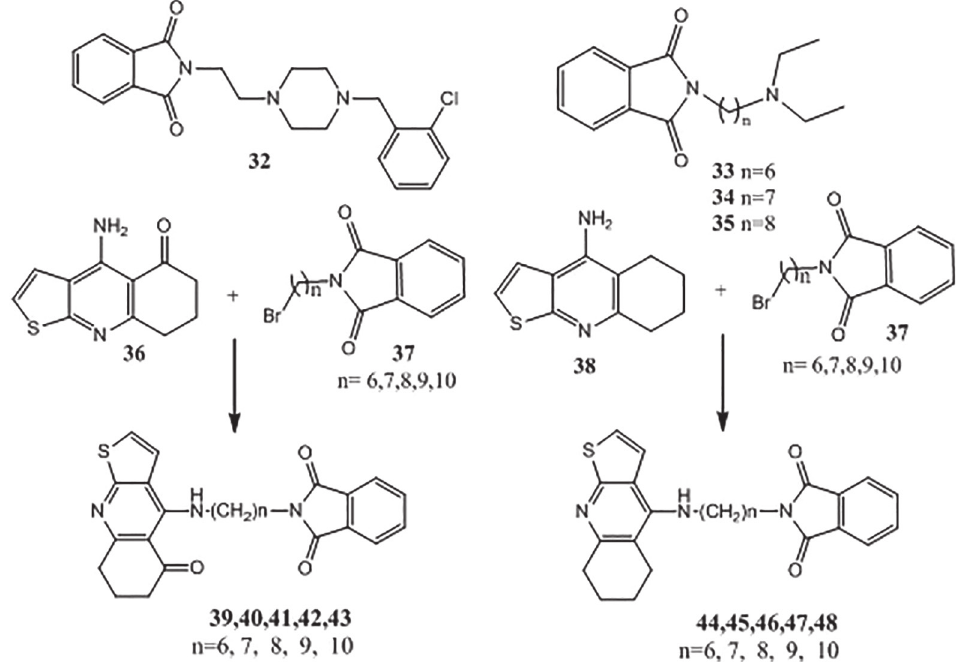
FIGURE 6 - Phthalimide derived